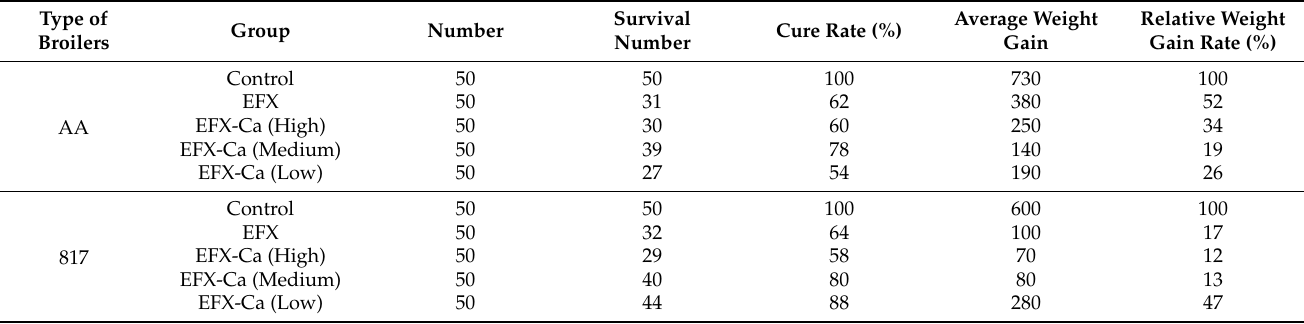
Table 7. The survival numbers, cure rates, and relative weight gain rates on two typical broilers after drug-mixed feeding of EFX and different dosages of EFX-Ca, respectively.